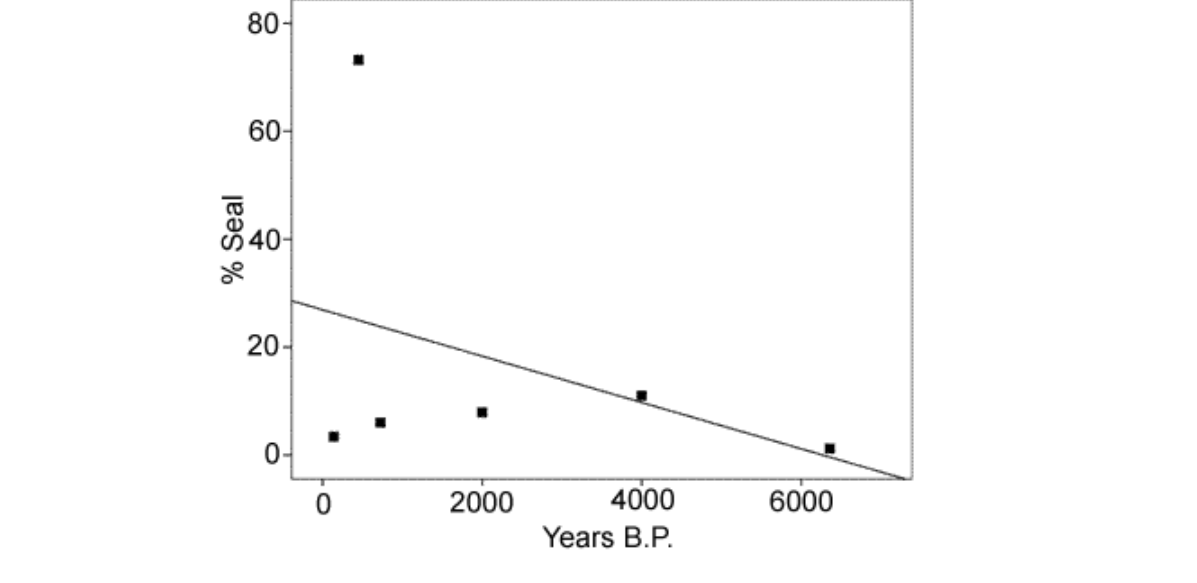
Fig. 5. Relative frequency of seal specimens (Phocidae, Otariidae) in mammal assemblages, south– central Northwest Coast sites located on rivers. Included all assemblages with sample size >30 identified specimens. Sites are Glenrose Cannery (three components) Duwamish, Hoko River Rockshelter, Sbabadid (one component). See Butler and Campbell (2004) for more site